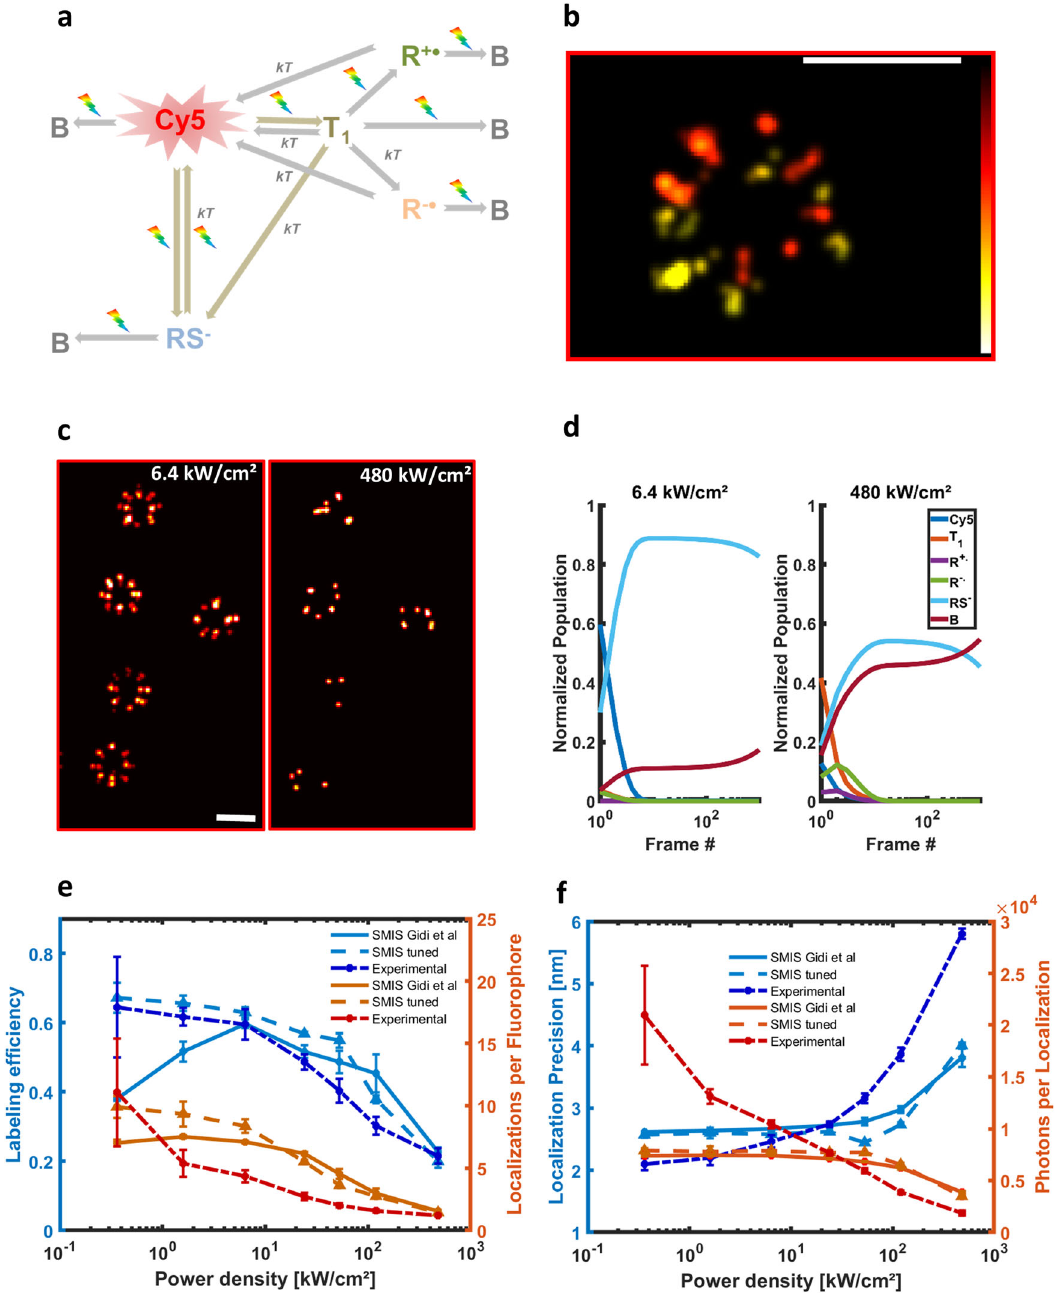
Fig. 3 dSTORM SMIS simulations of the Nuclear Pore Complex to investigate Cy5 photophysics. a Employed photophysical model of Cy5. T 1 : triplet state; B: bleached state; RS - : sulfur anion adduct; R + (cid:129) : radical cation; R − (cid:129) : radical anion; kT: thermal relaxation; rainbow arrow: light sensitivity. b 3D view of a reconstructed NPC (color map encodes position along optical axis, scale bar: 100 nm). c Rendered NPC ’ s using 6.4 kW/cm² (left) or 480 kW/cm² (right) 647 nm laser power density. 2D projections are shown. Scale bar: 100 nm. d Ensemble SMIS simulations showing the evolution of fractional populations of all photophysical states at 6.4 kW/cm² (left) or 480 kW/cm² (right) 647nm laser power density. e Measured labeling ef fi ciency (SMIS data, blue; experimental data, dark blue), and number of localizations per fl uorophore (SMIS data, orange; experimental data, red), as a function of the used 647 nm laser power density. Experimental data were taken from ref. 11 . Error bars for SMIS data show standard deviation for n = 3 simulations. Individual data points not shown for clarity. Plain lines: results using photophysical values of ref. 23 ; Dashed lines: re fi ned photophysical values. f Measured localization precision and number of photons per localization. Color and line coding identical to ( e